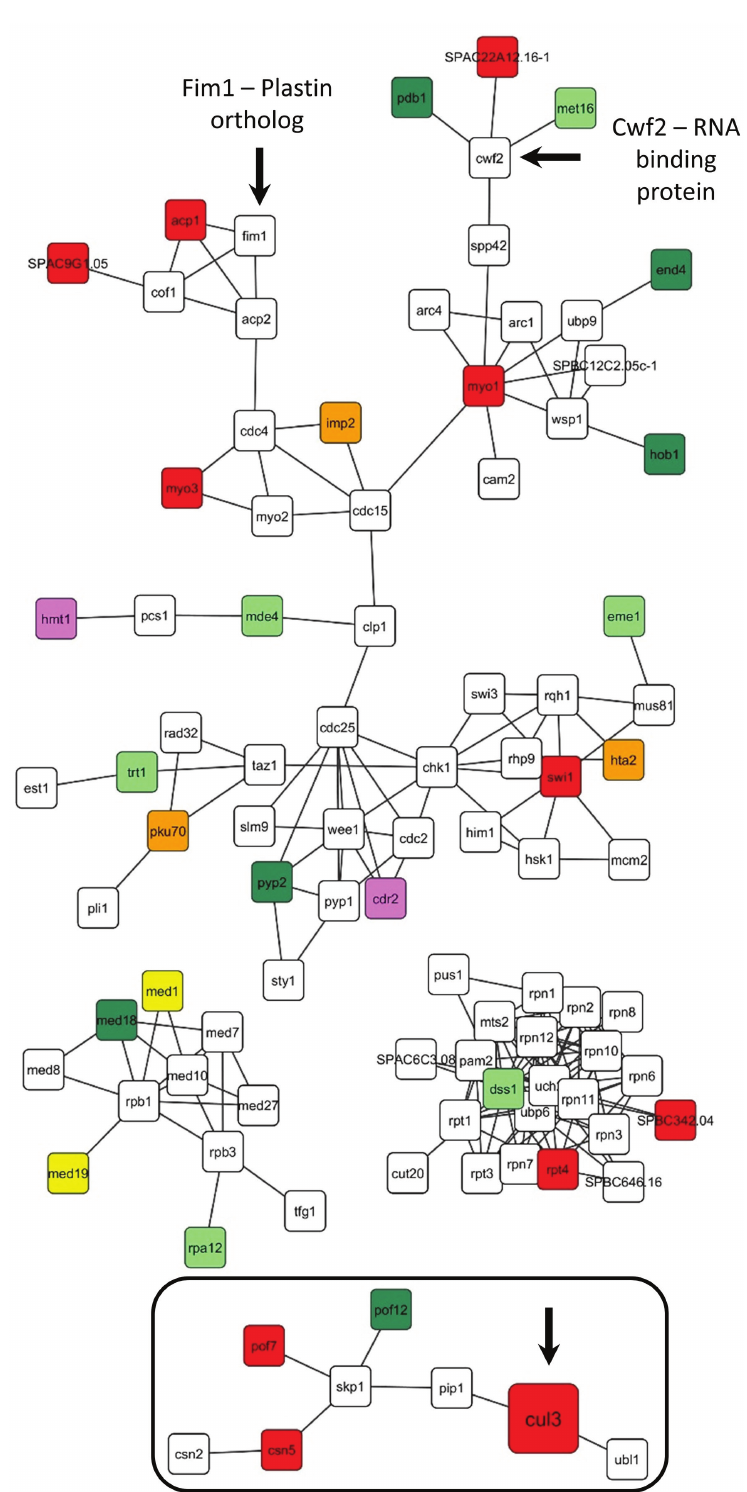
Figure 4. S. pombe extended UBA1 gene interaction network (extracted from Figure S1 on the basis of identifying new primary hit interactions through a 1° neighbor). Primary yeast gene hits from all four SGA screens were combined and mapped based on highest confidence experimentally confirmed protein-protein interaction data. For this extended analysis, we also included first-degree neighbors of modifiers that were not directly identified in the SGA screens. Only selected gene clusters are shown here; the complete extended network is shown in Figure S1. When extrapolated to human, the yeast extended network analysis identified Csn5 and Cul3, two modifiers also identified in our human UBA1 primary gene interaction network (boxed; see also Figure 3).